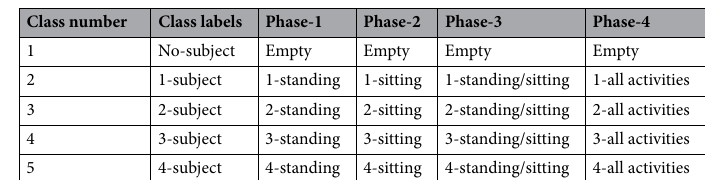
Table 4. Number of classes for all 4 phases for the subject count experiment.